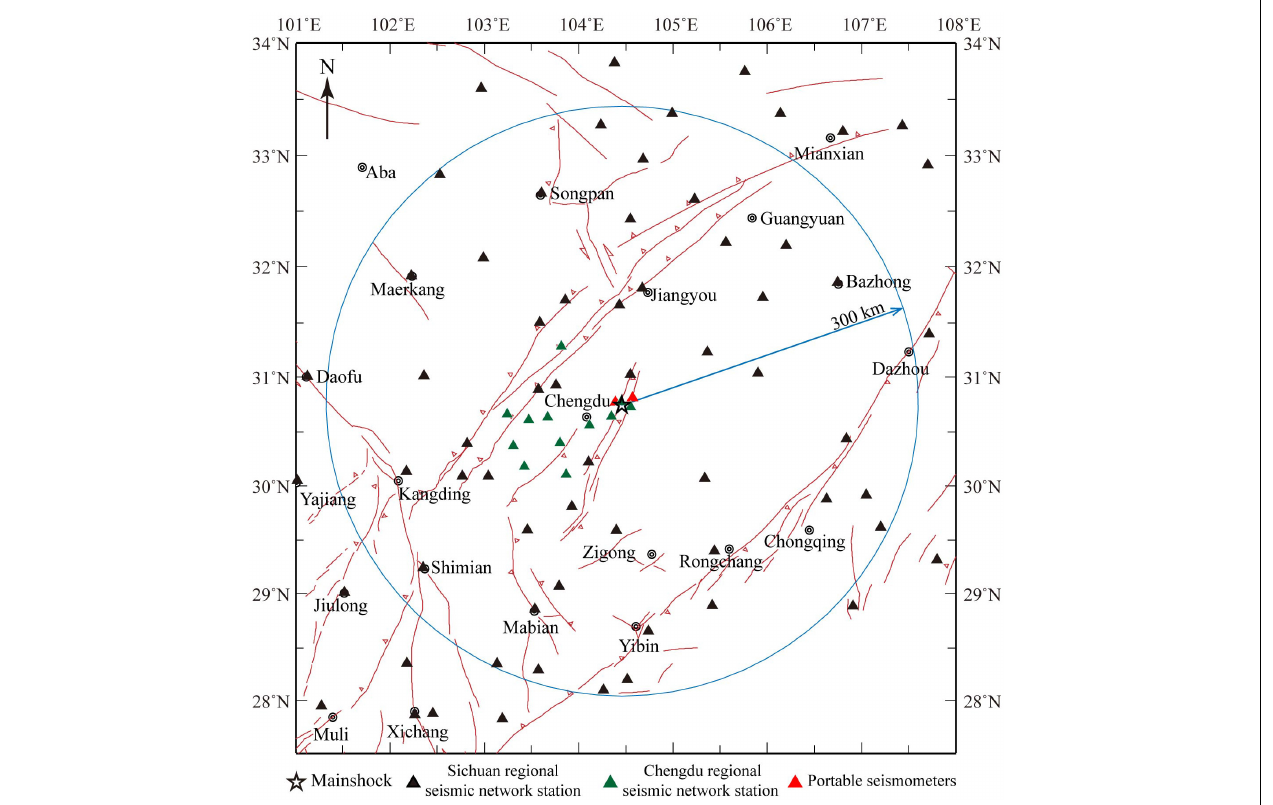
FIGURE 3 | Distribution of seismic stations (triangles) and known faults (red lines) around the epicenter of the M S 5.1 Qingbaijiang earthquake (star). There were 55 broadband seismic stations (black and green triangles) and two portable SP seismometers (red triangles) within a 300 km epicentral distance of the mainshock.